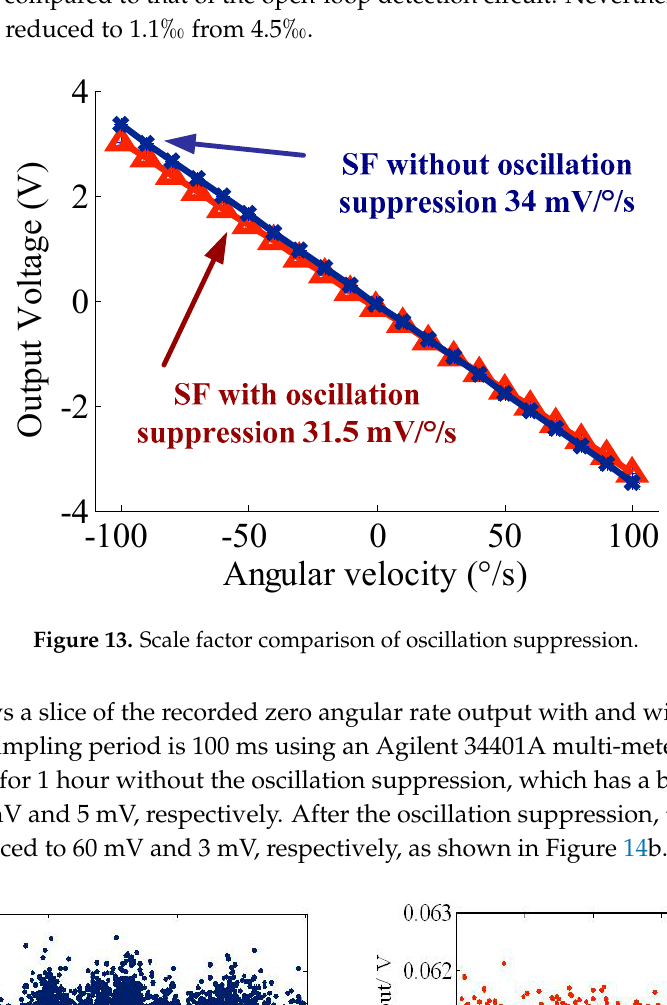
Figure 12. Transient response of the zero angular rate output: ( a ) without and ( b ) with oscillation suppression electronics.